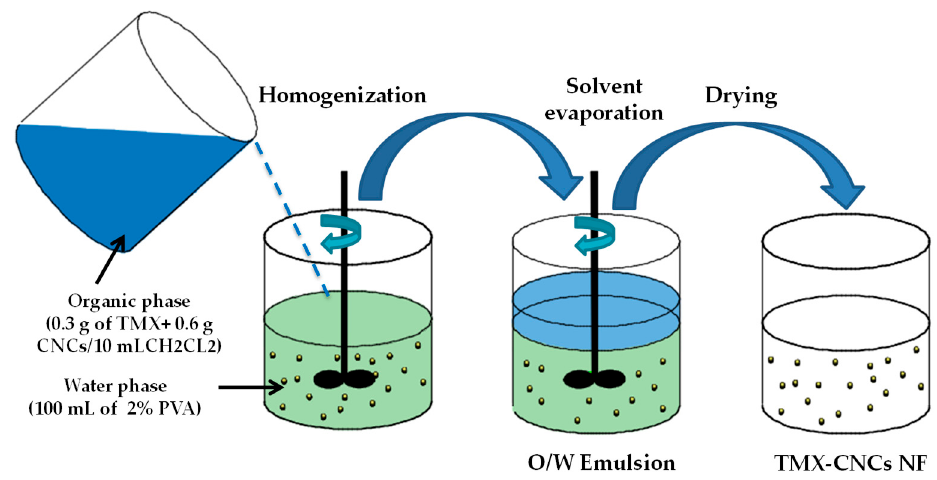
Figure 2. Schematic description of the preparation of the thiamethoxam (TMX)-loaded cellulose nanocrystals (CNCs).